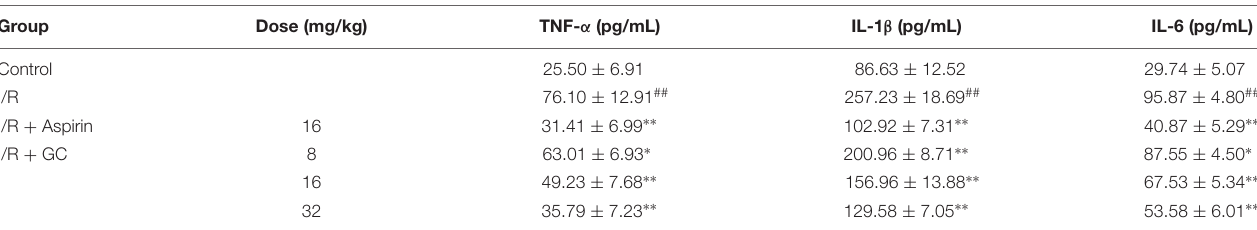
Values were expressed as mean ± SD (n = 8). ## P < 0.01 vs. control group; ∗ P < 0.05, ∗∗ P < 0.01 vs. I/R